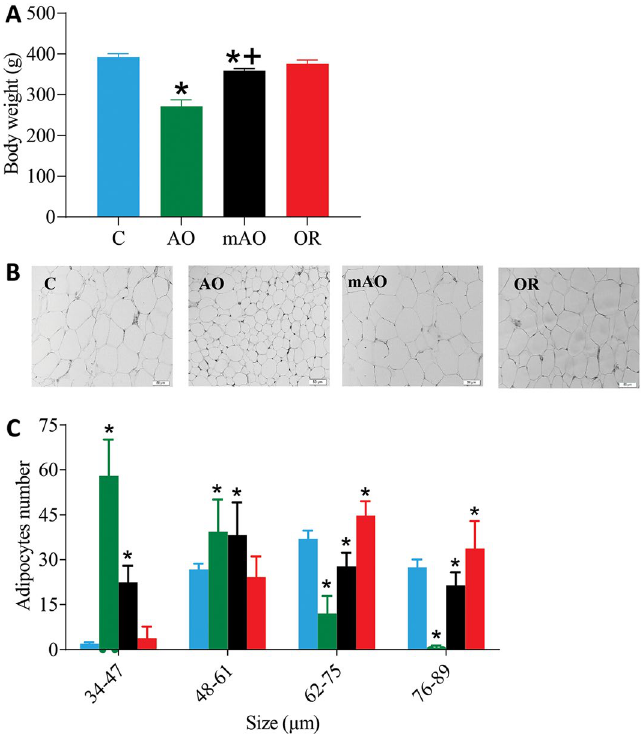
Figure 4. Retroperitoneal adipocyte analysis: (A) body weight; (B) histological images of retroperitoneal adipose tissue hematoxylin and eosin staining (magnification × 40); (C) adipocyte diameter; (C) frequency distribution of adipocyte size, bars represent the number of adipocytes; C control; AO obstruction; mAO mild obstruction; OR obstruction removal. Values are means ± SEM. * p < 0.01, C vs. AO or mAO group. In (B) , statistical differences were determined by a one-way ANOVA. In C, statistical differences were determined by two-way ANOVA, followed by a post-hoc Student–Newman–Keuls